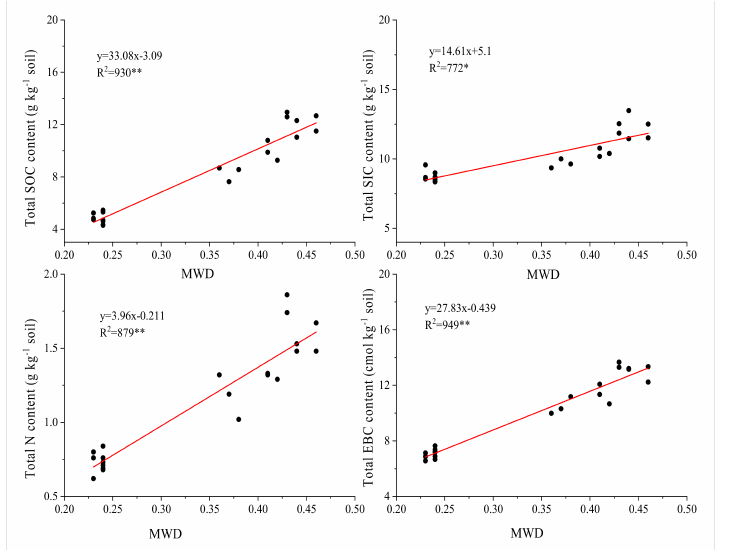
Figure 1. Relationship between total SOC, total SIC, TN, ECtot and aggregate stability in terms of mean weight diameter (MWD). * and ** indicate significance at p < 0.05 and p < 0.01,